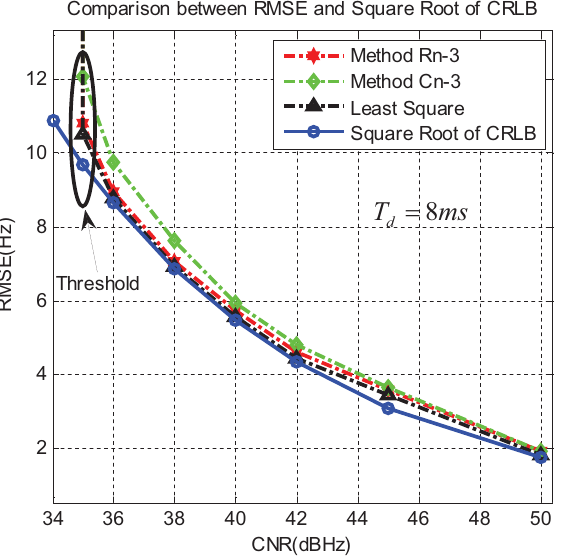
Results of second group of experiments, with T d = 8 ms. false